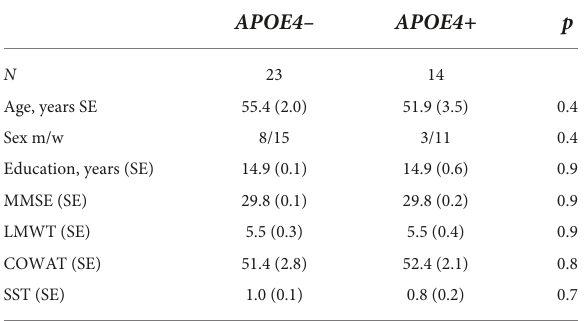
TABLE 2 Demographic and psychometric characteristics of participants with fMRI